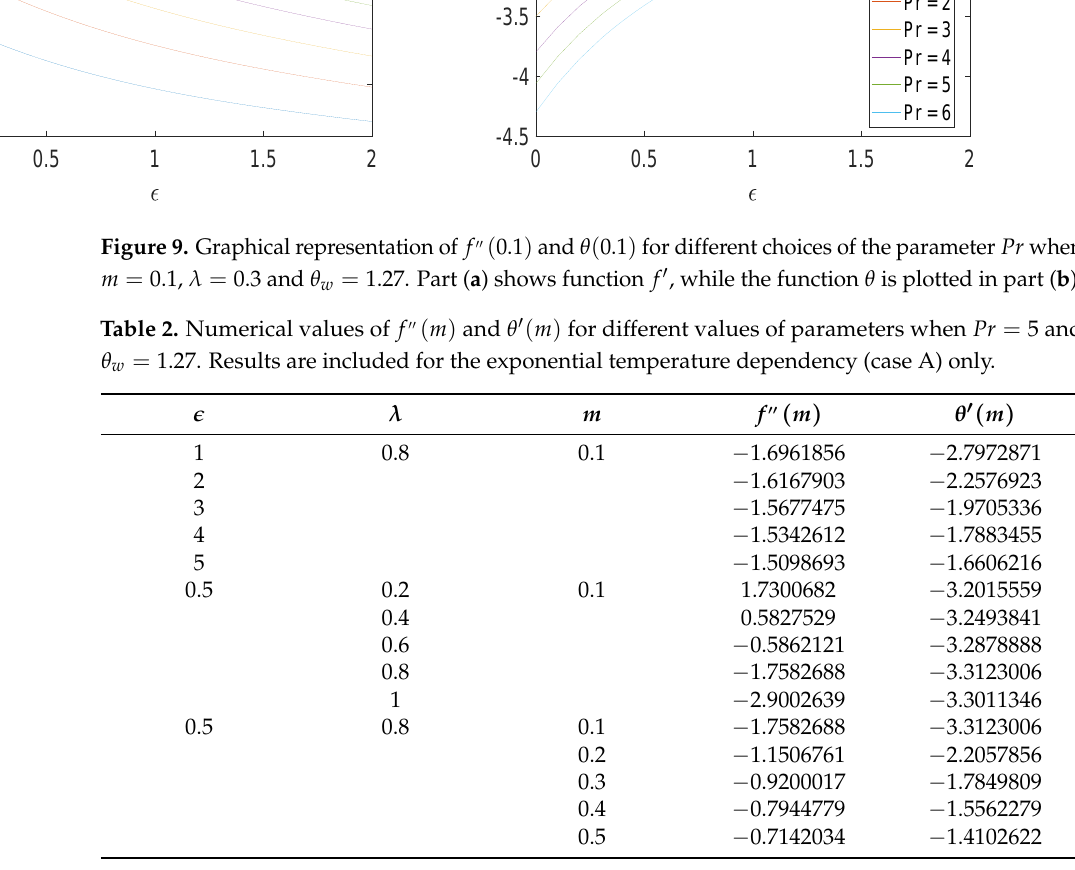
10 of 14 Figure 7. Axial velocity and temperature profiles for different values of parameter 𝜃 (cid:3032) when 𝜆 (cid:3404) 0.8 , Pr (cid:3404) 5 , 𝑚 (cid:3404) 0.1 and 𝜖 (cid:3404) 0.5 . Part ( a ) shows function 𝑓′ , while 𝜃 is plotted in part ( b ).